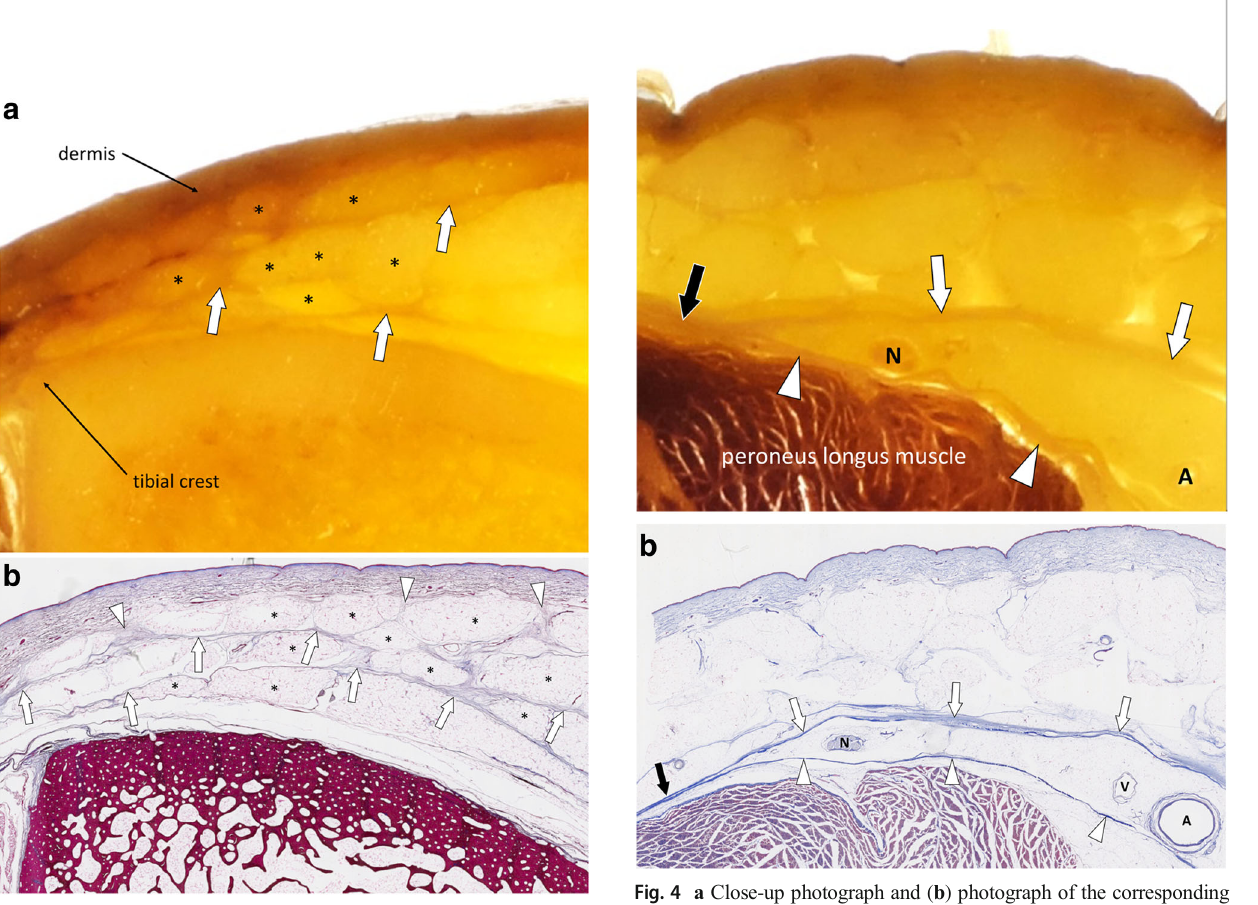
Fig. 3 a Close-up photograph and ( b ) photograph of the corresponding microscopic image (Masson ’ s trichrome stain) of the subcutaneous tis- sues ofthe antero-medialpart ofthe leg(blue squareinFig.1). Fatlobules (asterisks) are delimited by connective tissue tracts (arrowheads) an- chored to the dermis. These tracts of connective tissue converge and constitute the fascia superficialis